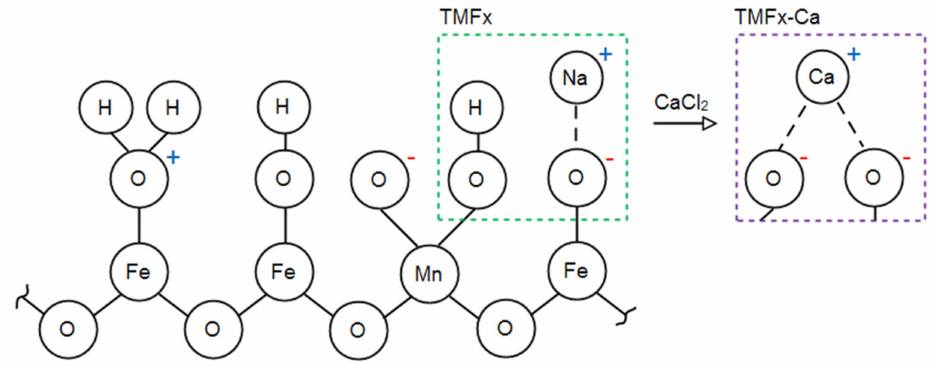
Figure 3. Proposed surface charge distribution (positive, negative, and neutral) for the TMFx and TMFx-Ca